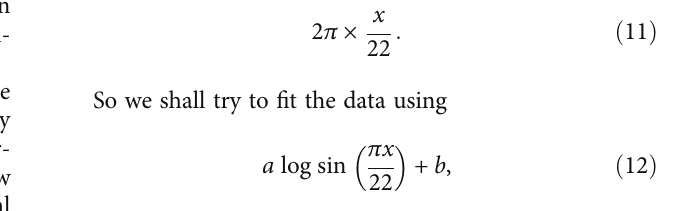
and τ = τ and provides a map from low-energy states ( τ = τ 1 2 , τ again denote di ff erent energy scales, and τ = 0 corresponds to the UV cuto ff 1 2